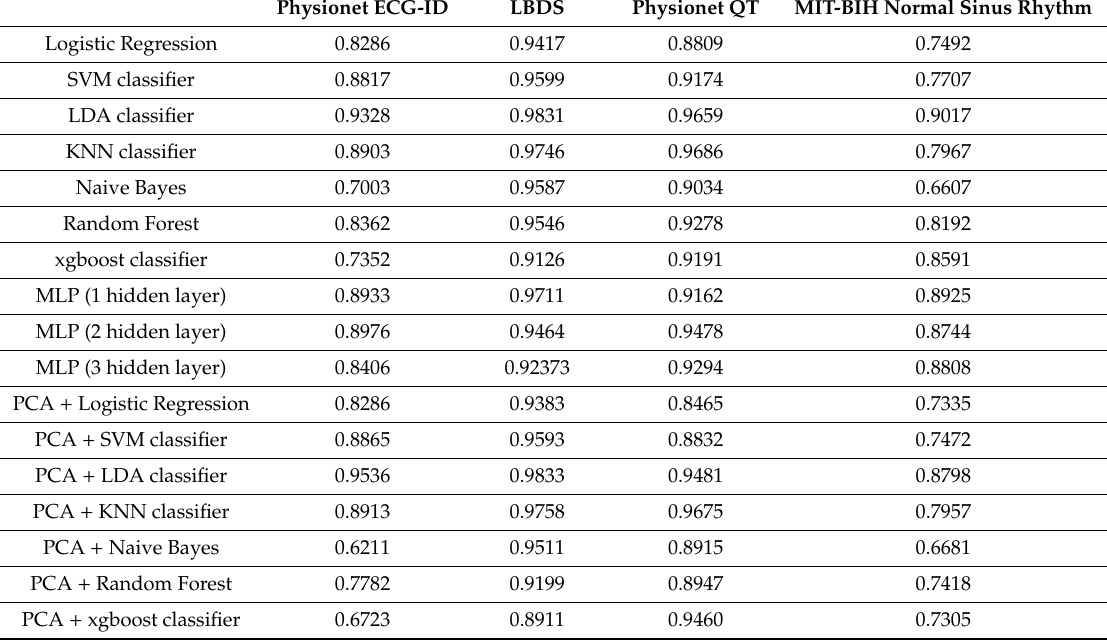
Table 2. ECG identification